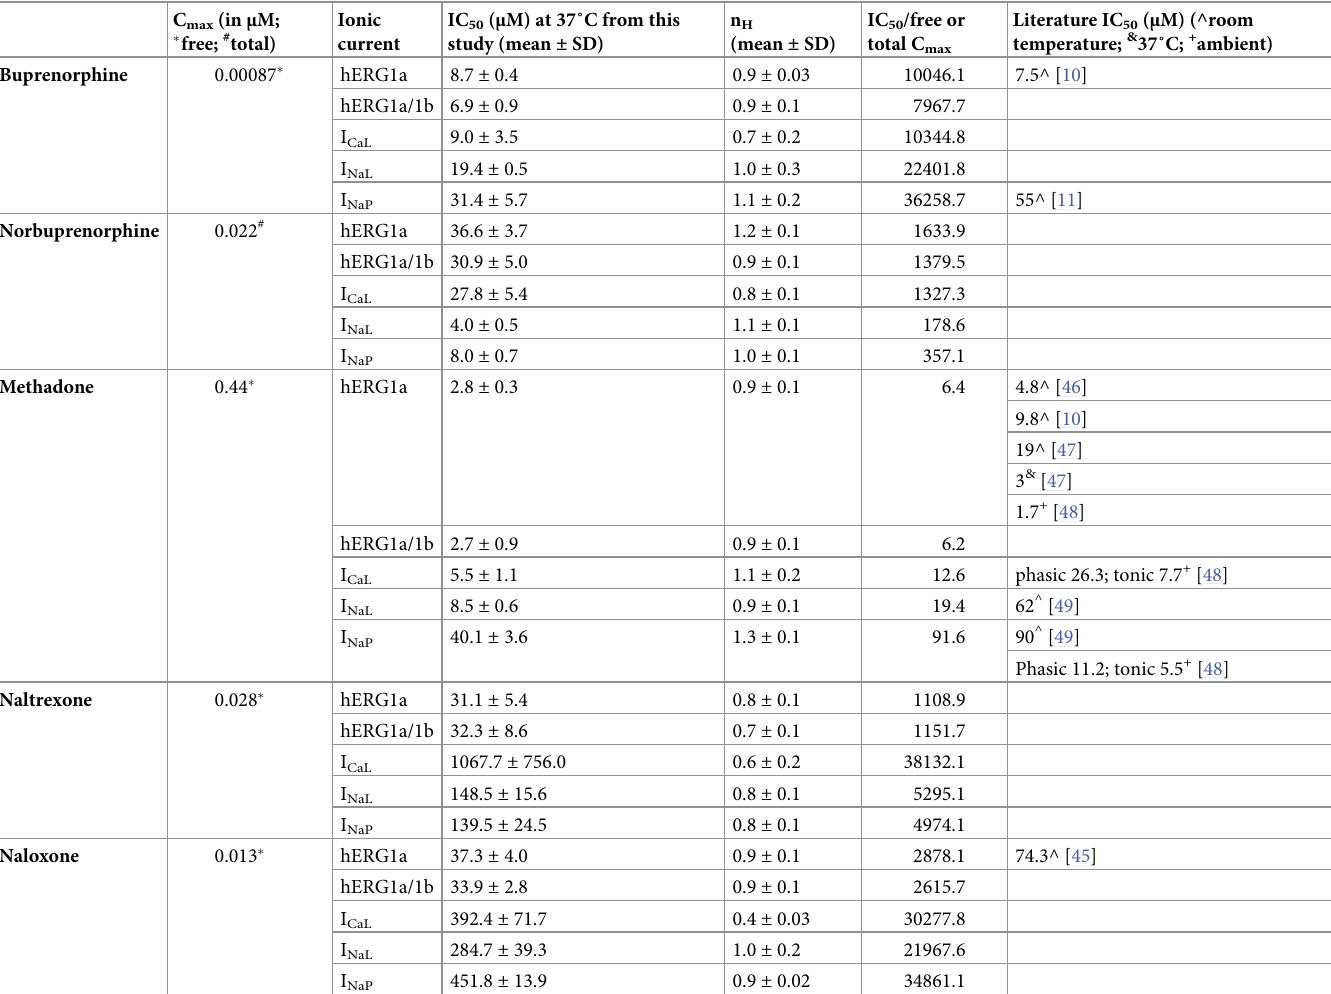
Table 1. Potencies of buprenorphine, norbuprenorphine, methadone, naltrexone, and naloxone on inhibiting I hERG , I CaL , I NaL , and I NaP . C max (in μ M; � free; #